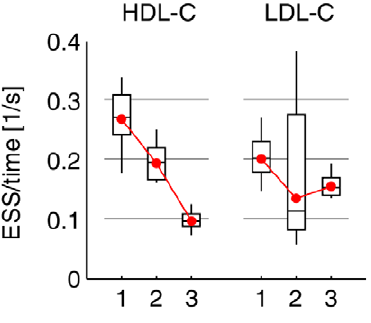
Table 1. Move size and rate statistics as averages over the MCMC chains for HDL-C and LDL-C